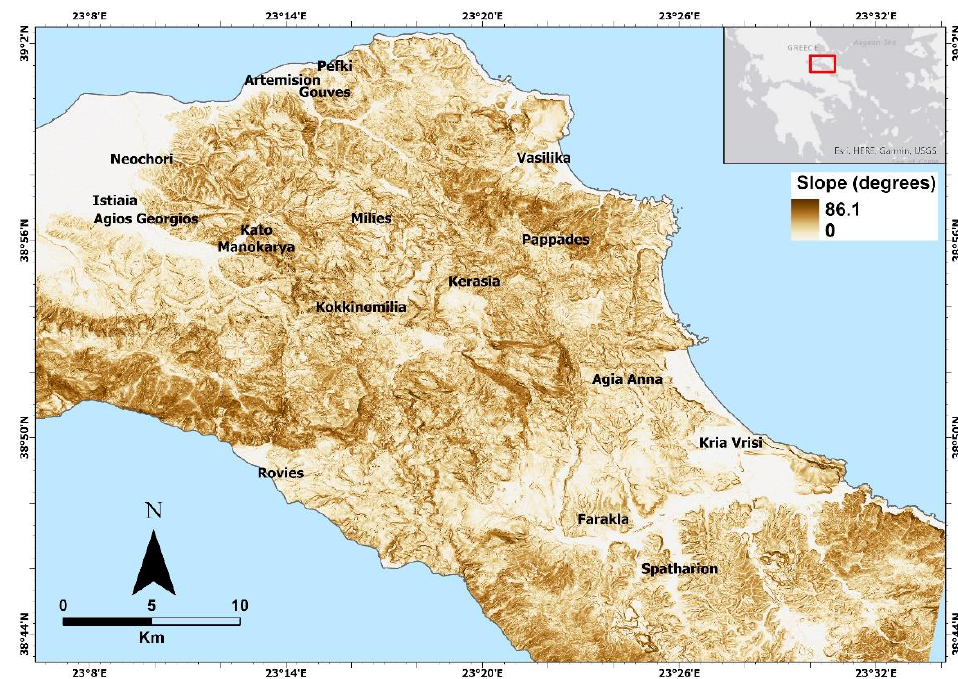
Figure 6. Morphological slopes of the fire-affected area in Northern Euboea.